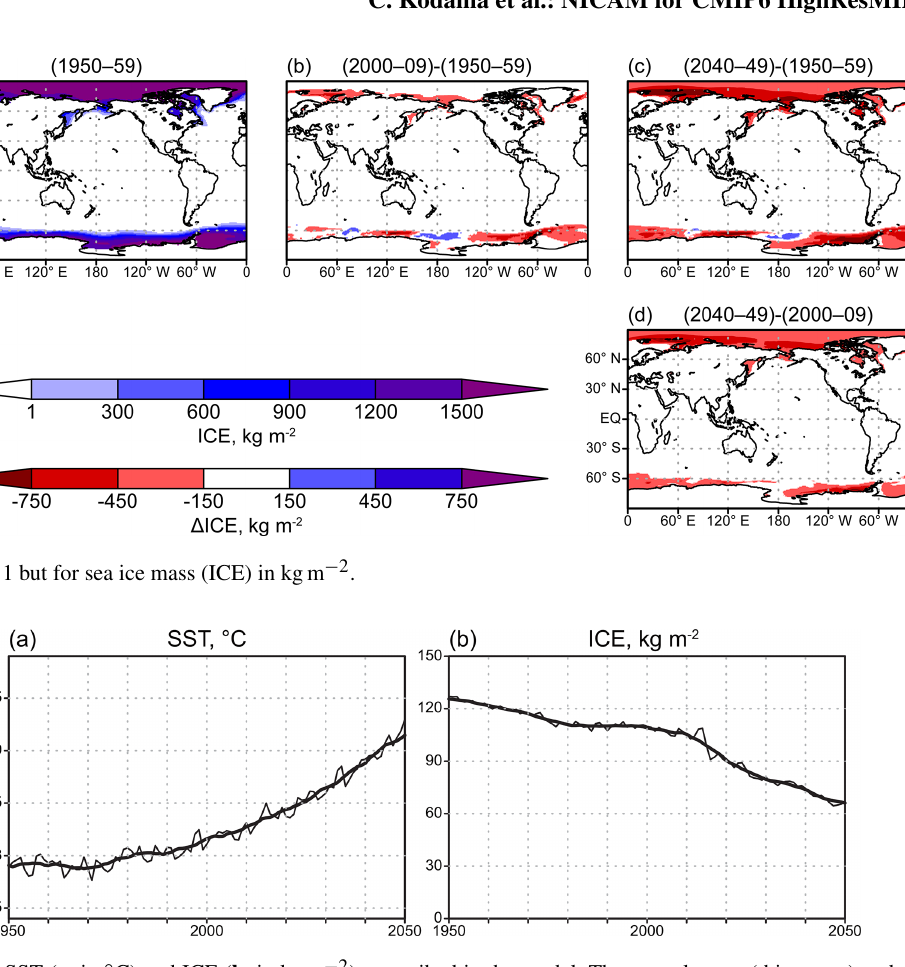
Figure 3. Global mean SST ( a ; in ◦ C) and ICE ( b ; in kgm − 2 ) prescribed in the model. The annual mean (thin curve) and decadal running mean (thick curve) are